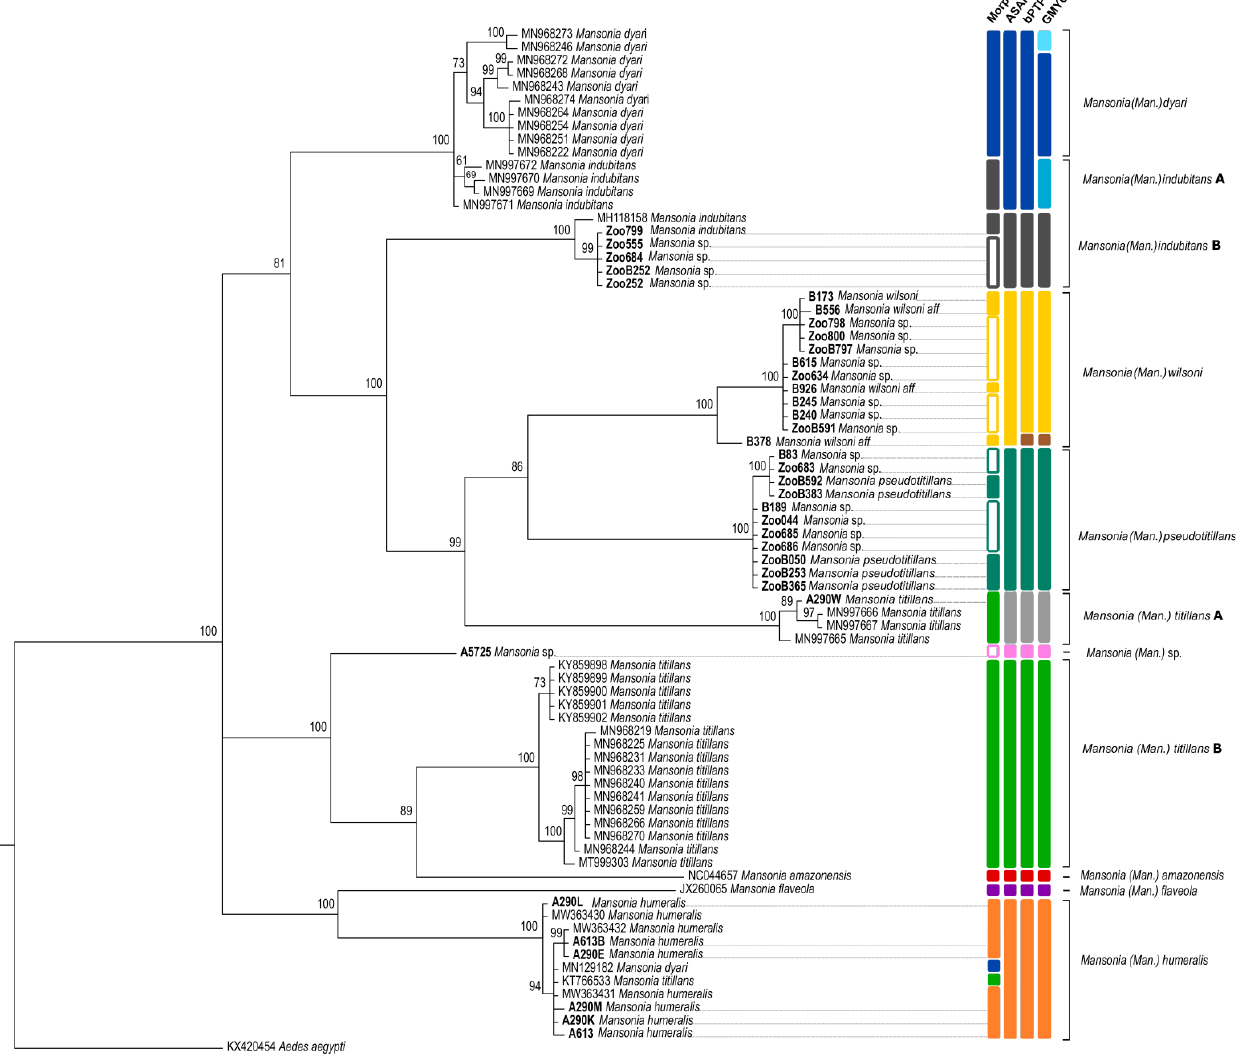
Figure 5. Bayesian inference tree based on the cytochrome c oxidase I ( COI ) barcoding region of Mansonia ( Man .) species. This analysis involved 77 nucleotide sequences. Aedes aegypti (KX420454) was used as an outgroup. There was a total of 641 positions in the final dataset. Average standard deviation of the split frequencies was 0.004342. Posterior probability values are shown for each clade. Specimens colored blank in the morphology column were not morphologically identified to species level due to a lack of important characters. Sequences obtained in this study are given in bold.